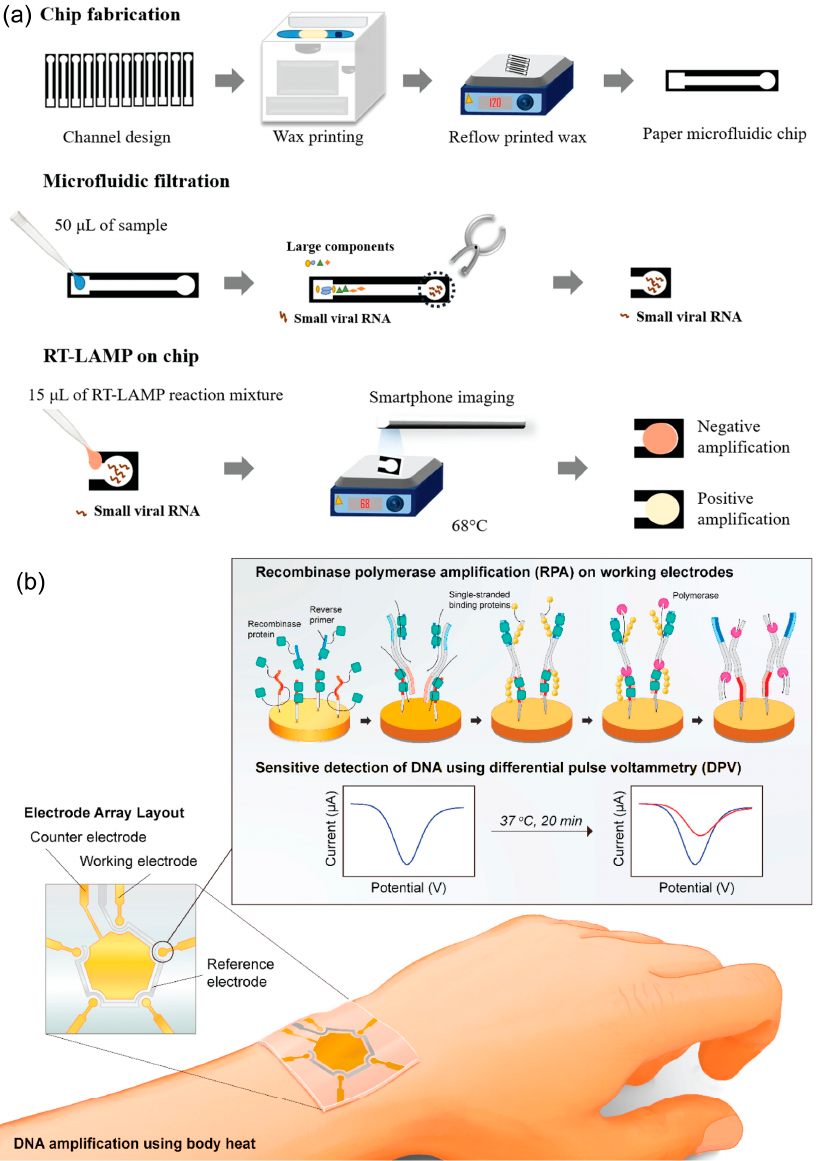
Figure 7. ( a ) Schematic representation of the paper micro fl uidic RT-LAMP assay for rapid detection of the Zika virus. Reprinted with permission from [106]. Copyright (2018) Springer Nature. ( b ) Sche- matic representation of the electrochemical biosensor combined with isothermal ampli fi cation for COVID-19 detection. Reprinted with permission from [102]. Copyright (2021) Elsevier.